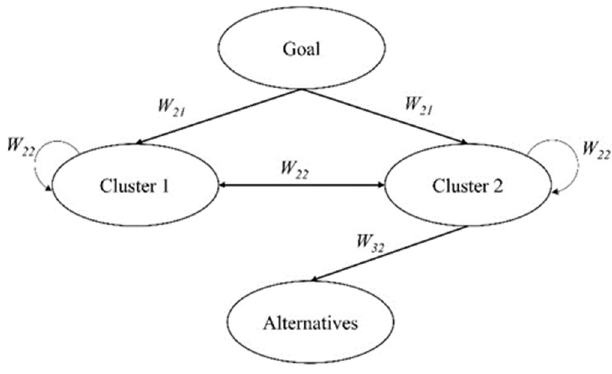
Figure 1. The analytic network process